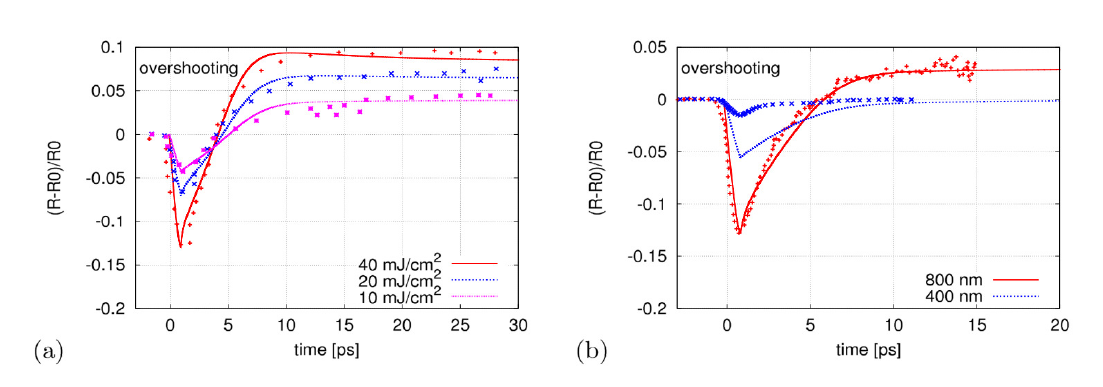
Figure 10. Relative change of transient reflectivity in GaAs as a function of the pump-probe time delay measured by: (a) the experiment [9] (probe pulse of 800 nm); (b) the experiment [33] (probe pulses of 400 and 800 nm; points), compared to our simulation results (solid line). The figure is reproduced from Ref. [32].